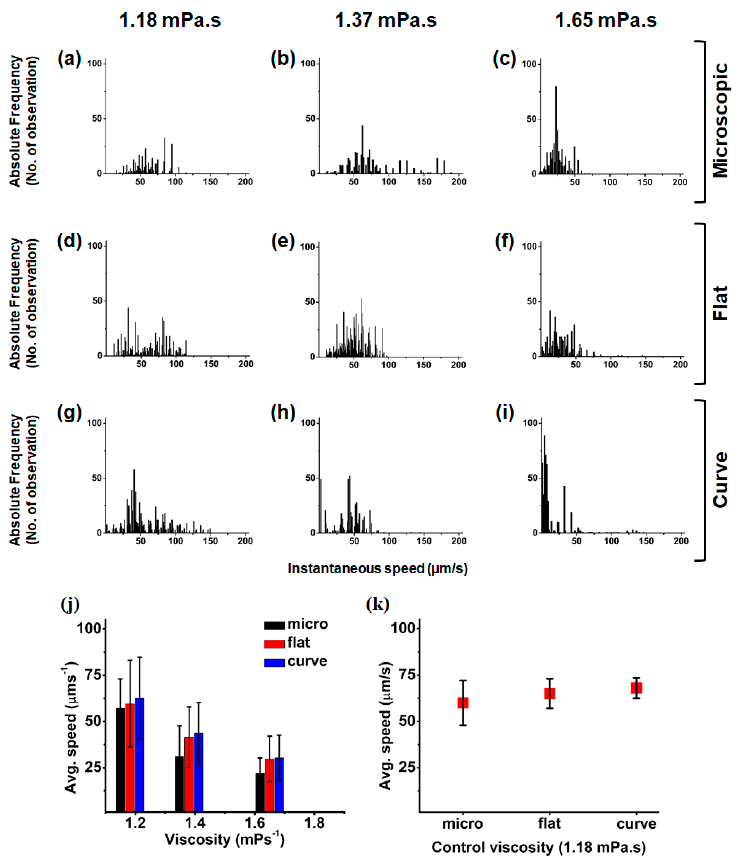
Figure 3. The instantaneous speeds of the microswimmers with histogram plots for the microscopic flat-chamber images ( a – c ); Large field-of-view (FOV) flat-chamber images ( d – f ); and large FOV curved-chamber images ( g – i ); The image sequences for 2 min were analyzed. The sample solution to which 0%, 5%, and 10% methylcellulose (MC) added is depicted in each column, respectively; ( j ) The average speeds of microswimmers in three different viscous media are illustrated in the plot. With increasing viscosity, the average speed decreases. All the three media exhibit the similar speed trends; ( k ) The plot depicts the average speeds of the microswimmers in the same viscous medium that is placed in three different sample chambers. In microscopic view, the deviation is observed to be larger than that in a large FOV image. The deviation is observed to be even smaller in the curved chamber, as compared to the flat chamber.